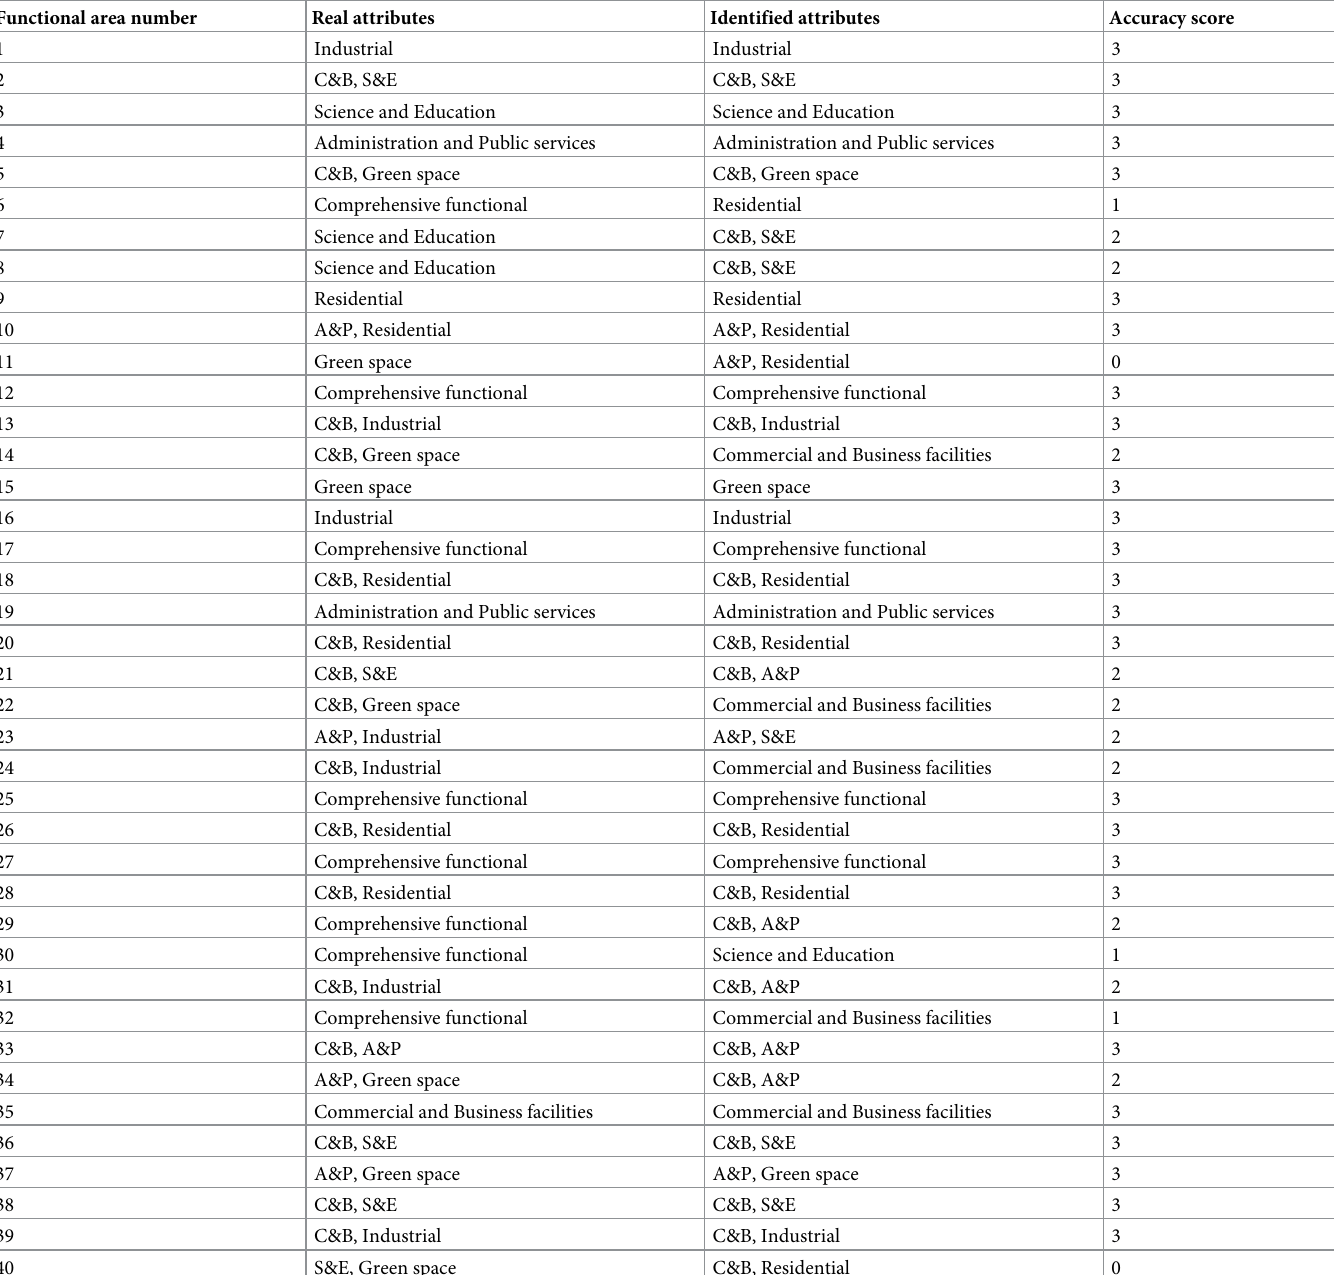
Table 5. Accuracy evaluation of urban functional area. Functional area